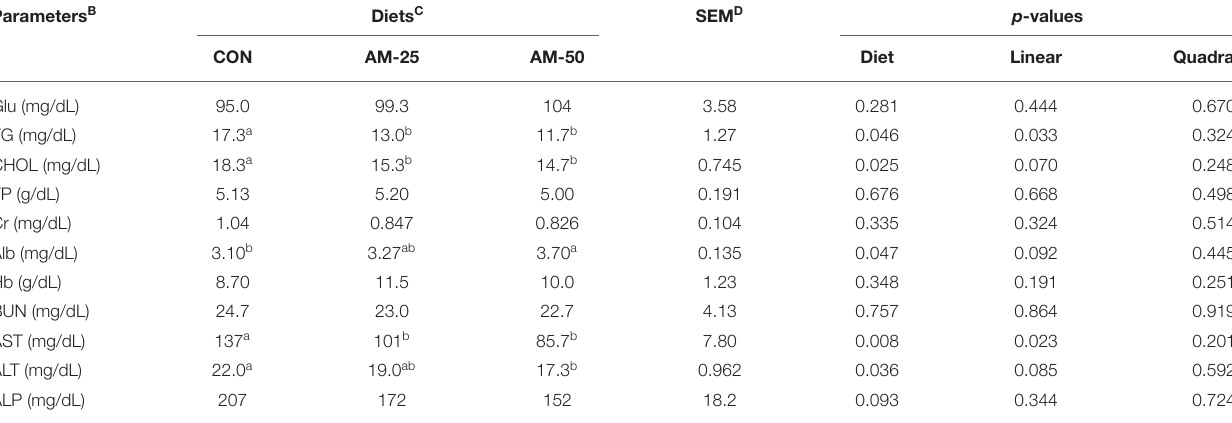
TABLE 3 | Liver-related blood parameters of growing camels fed experimental diets A . Parameters B Diets C SEM D p -values